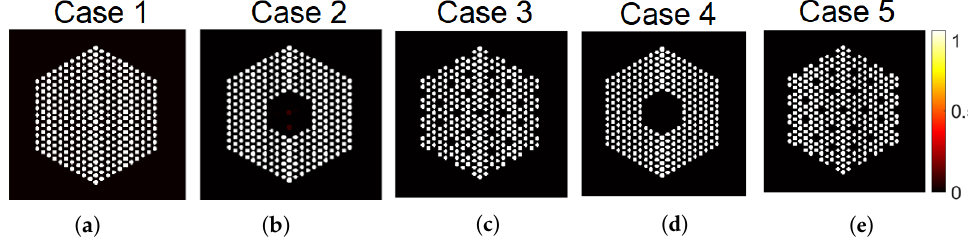
Figure 14. The IDEAL response matrix: Probability of presence of pins using the proposed approach for the Poisson noise model. ( a ) Case “1”; ( b ) Case “2”, ( c ) Case “3”, ( d ) Case “4” and ( e ) Case “5”. The Gaussian noise model showed similar trends and hence not presented.